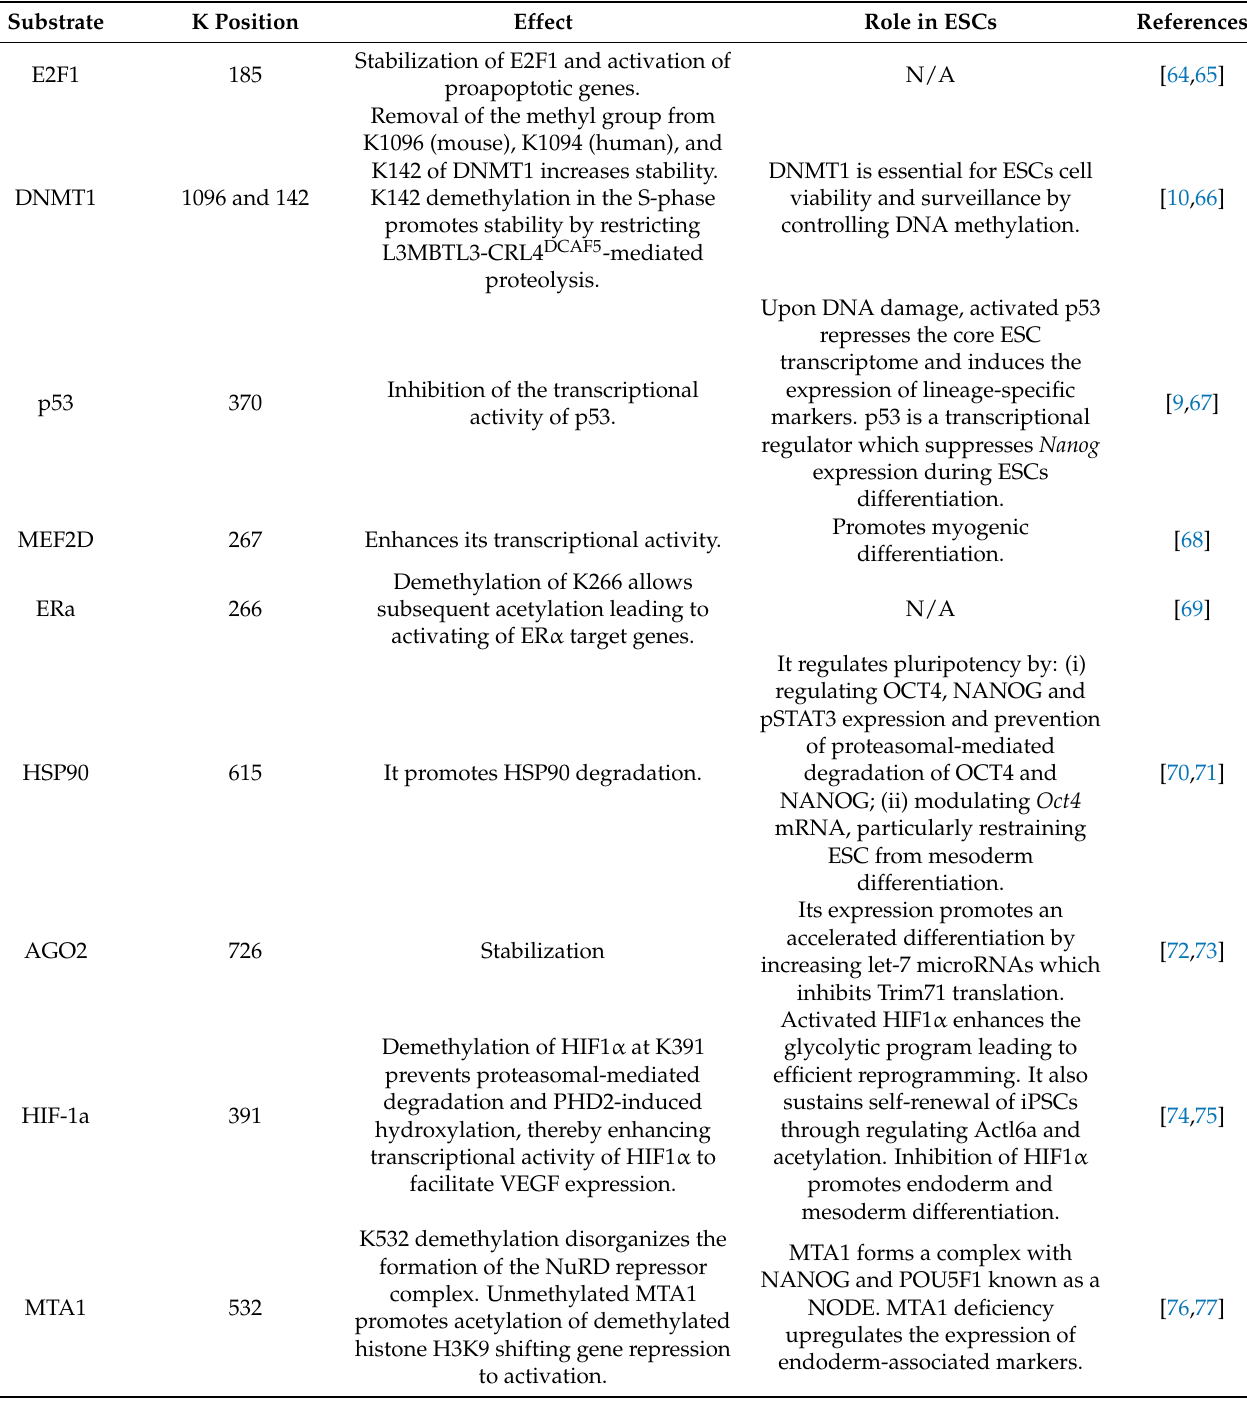
Table 2. Non-histone substrates of LSD1. Name of the substrate, the effect of Lys demethylation and the role (if any) in ESCs are